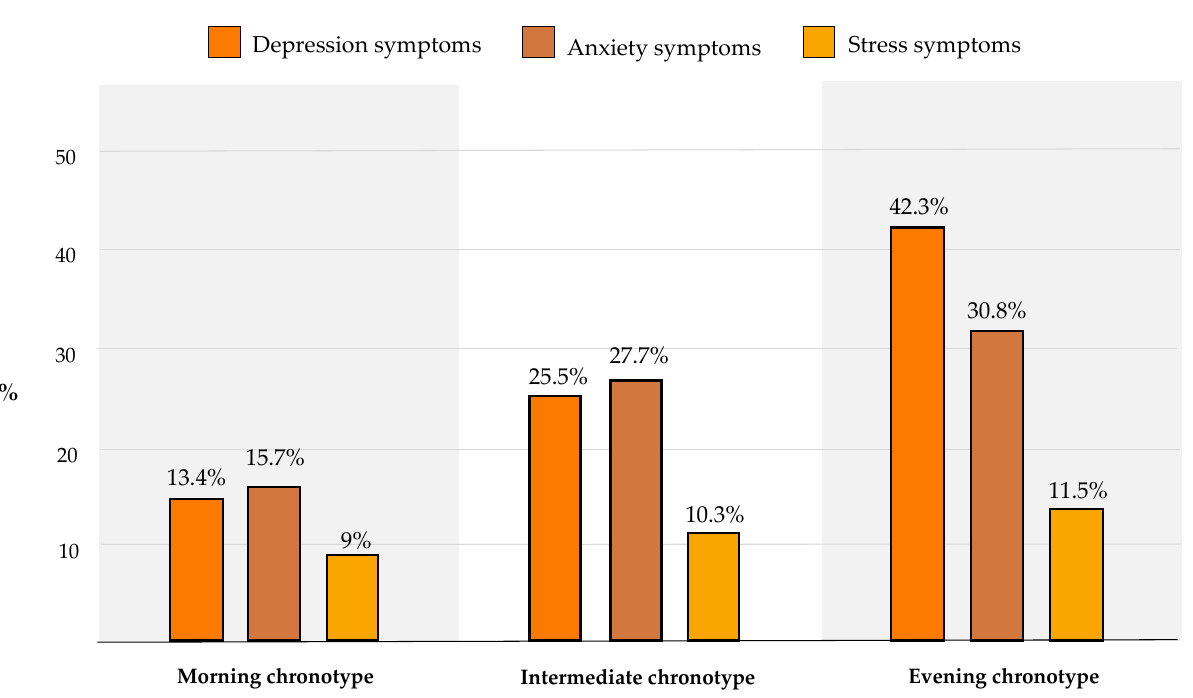
6 of 12 Figure 2. Percentage of participants reporting the optimal choice (i.e., the choice that gave 2 points) for the individual food components of the Medi-Lite score according to the presence (in red)/absence (in green) of symptoms of depression, anxiety, and stress (* p -value < 0.05).